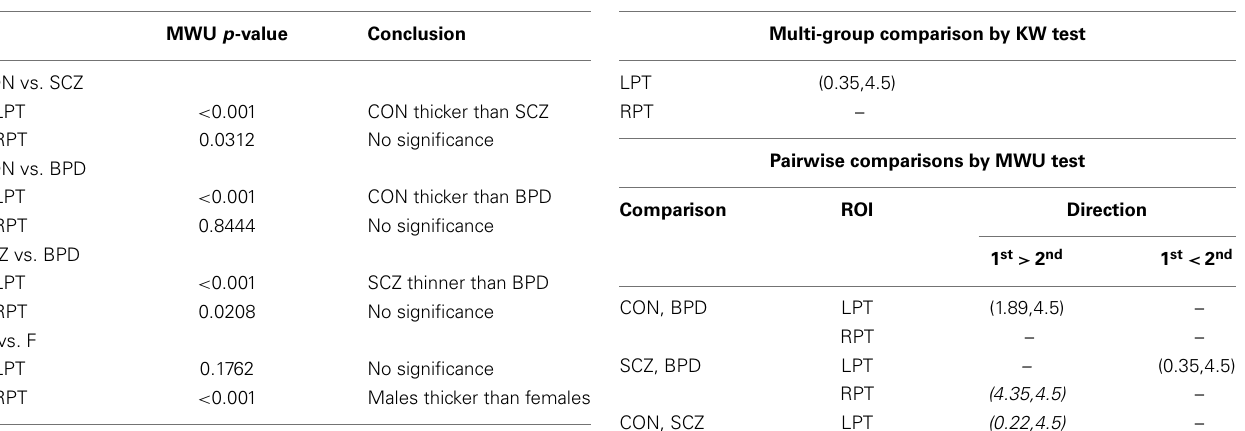
Table 1 | Comparison of thickness (mm) in diagnostic groups and gender with pooled LCDM analysis .